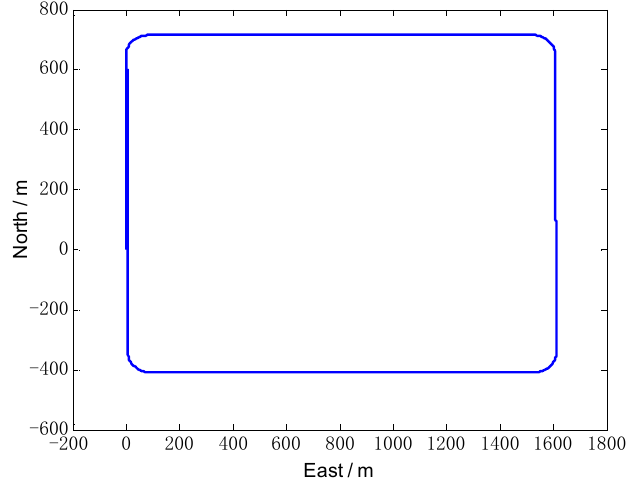
Figure 2. The vehicle’s simulation trajectory.